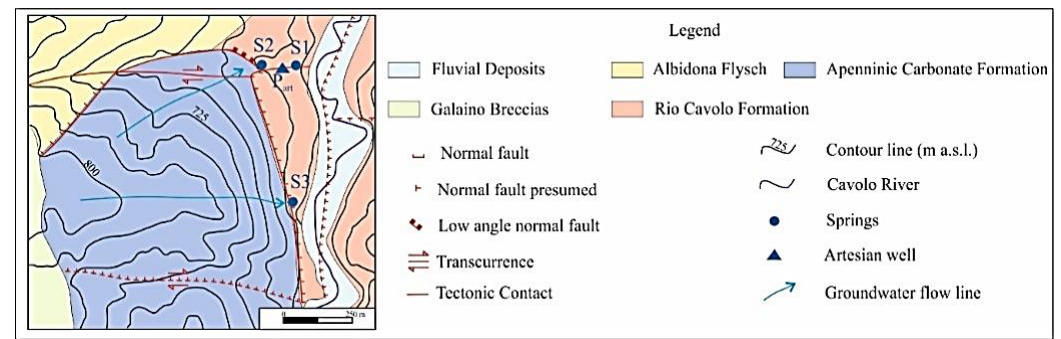
Figure 3. Hydrocarbon springs S1 ( a ) and S2 ( b ) .